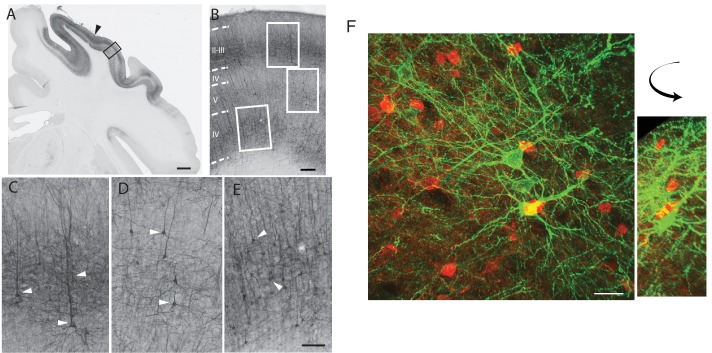
Opsin expression was observed only in pyramidal neurons.Using immunohistochemistry, we confirmed that EYFP reporter expression was present in both S1 and M1. YFP-positive cells in these areas were morphologically identified as pyramidal neurons, and were in layers II-III, V-VI. To confirm this we further analyzed the tissue using markers for inhibitory neurons such as parvalbumin, somatostatin and calbindin as well as GAD67/65 and examined cell bodies and axonal terminals at the areas around the site of infusion. We found no evidence for co-localization between EGFP and any of the inter-neuronal markers therefore excluding the possibility for significant opsin presence in cells other than pyramidal neurons, and confirmed that optical stimulation was selectively activating excitatory pyramidal neurons in M1 and S1. (A) Low magnification image of the coronal section processed anti-GFP antibody showing the medio-lateral aspect of YFP expression in the somatosensory cortex of monkey J (areas 1, 2, 3). The black arrowhead indicates the location of the injector needle track; the adjacent tissue (black frame) is microscopically enlarged in B to show laminar distribution of the YFP-positive cells. In monkey G (Yazdan-Shahmorad et al., 2016), we saw some cortical thinning post-mortem. In contrast, the histology for monkey J, presented here does not show change in the cortical thickness. (B) Densely YFP-positive cells are located predominantly in layers II-III and V-VI, and also show typical pyramidal morphology (cells in white frames are further enlarged in panels C-E). White arrowheads on bottom panels C-E point to typical pyramidal cells in layers II-III (C); layer V (D); and layer VI (E). Scale bars: A, 2 mm; B, 200 μm; C-E, 100 μm. (F) Stained parvalbumin neurons (red) and YFP-expressing cells (green), no overlap indicated high specificity. Scale bar: 30 μm.